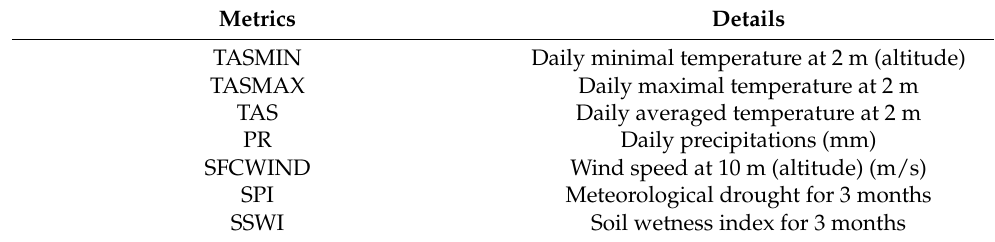
Table 2. EURO-CORDEX and Climsec